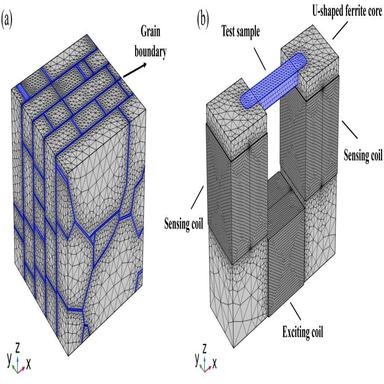
(a) 3D FE micro-grain mode, (b) 3D FE model of the macro sensor.